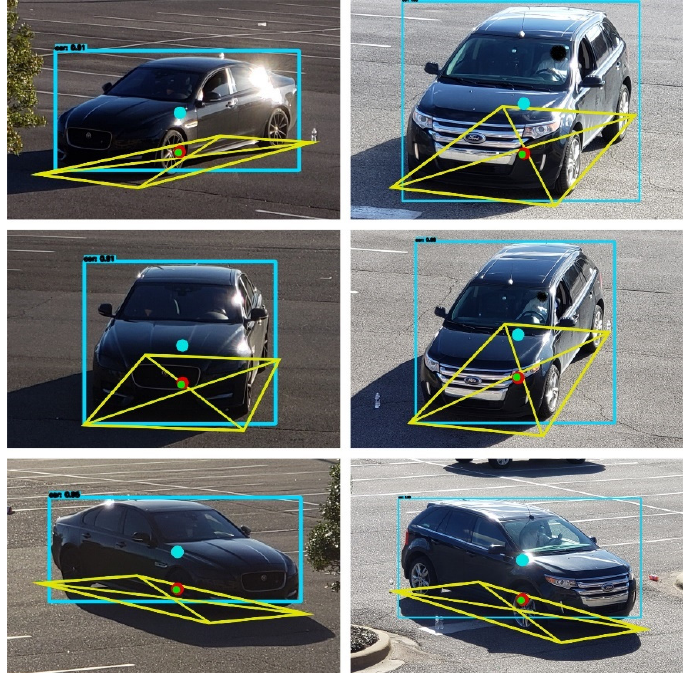
Figure 6 . Corrected center positions of two vehicles with di ff erent orientations . Figure 6. Corrected center positions of two vehicles with different orientations. Table 1. Comparison of vehicle center error corrections by linear and nonlinear regression models (better results shown in